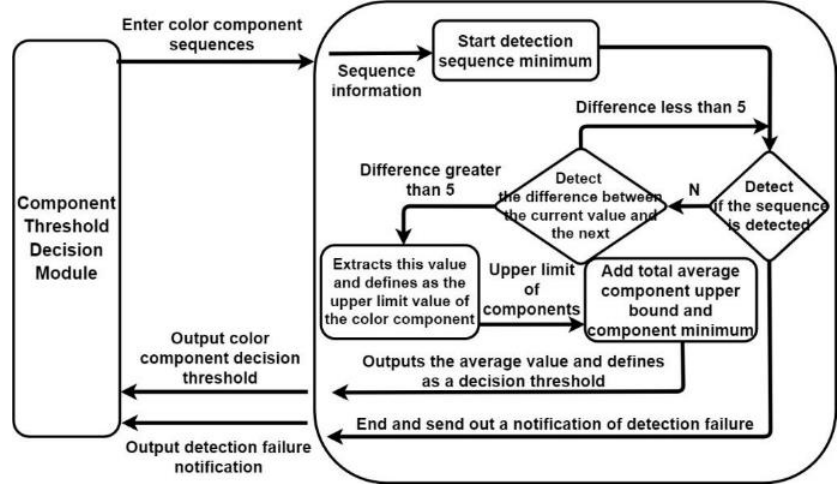
Figure 17. Architecture of the developed component threshold decision module.